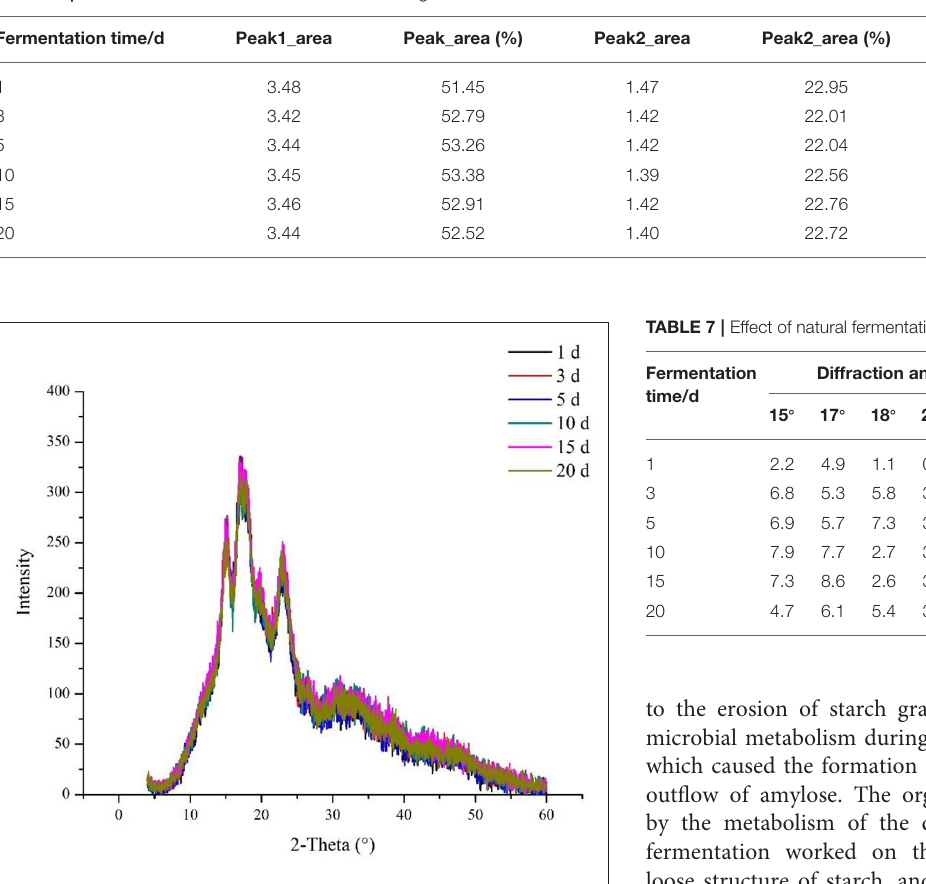
FIGURE 4 | Effect of natural fermentation on the crystallinity of corn ballast starch.